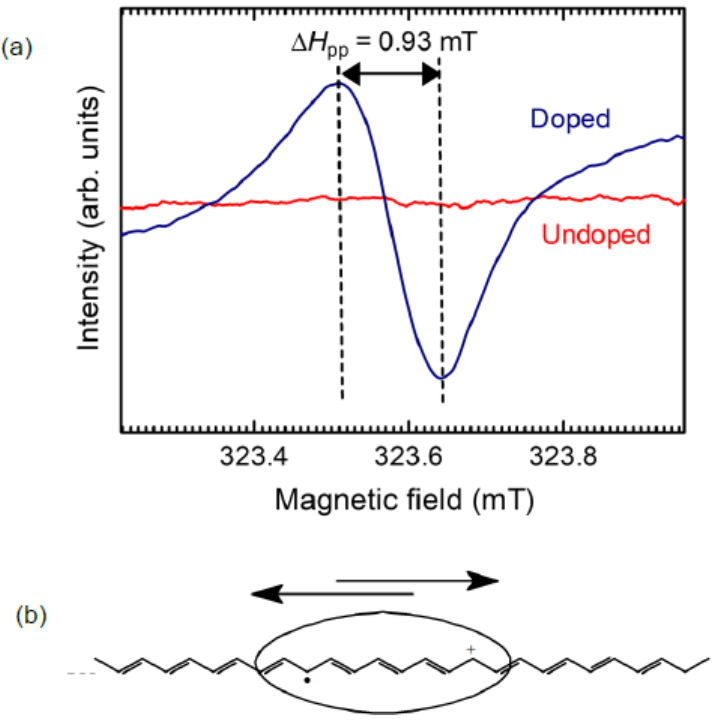
Figure 14. Electron spin resonance (ESR) absorption spectra of poly(Ac–Pyr ( a ). Solitons in Figure14. Electronspinresonance(ESR)absorptionspectraofpoly(Ac–Pyr( a ). Solitonsinpolyacetylene( b polyacetylene ( b ).